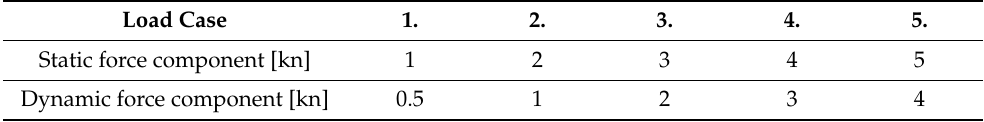
Table 1. Selected load cases for three-point